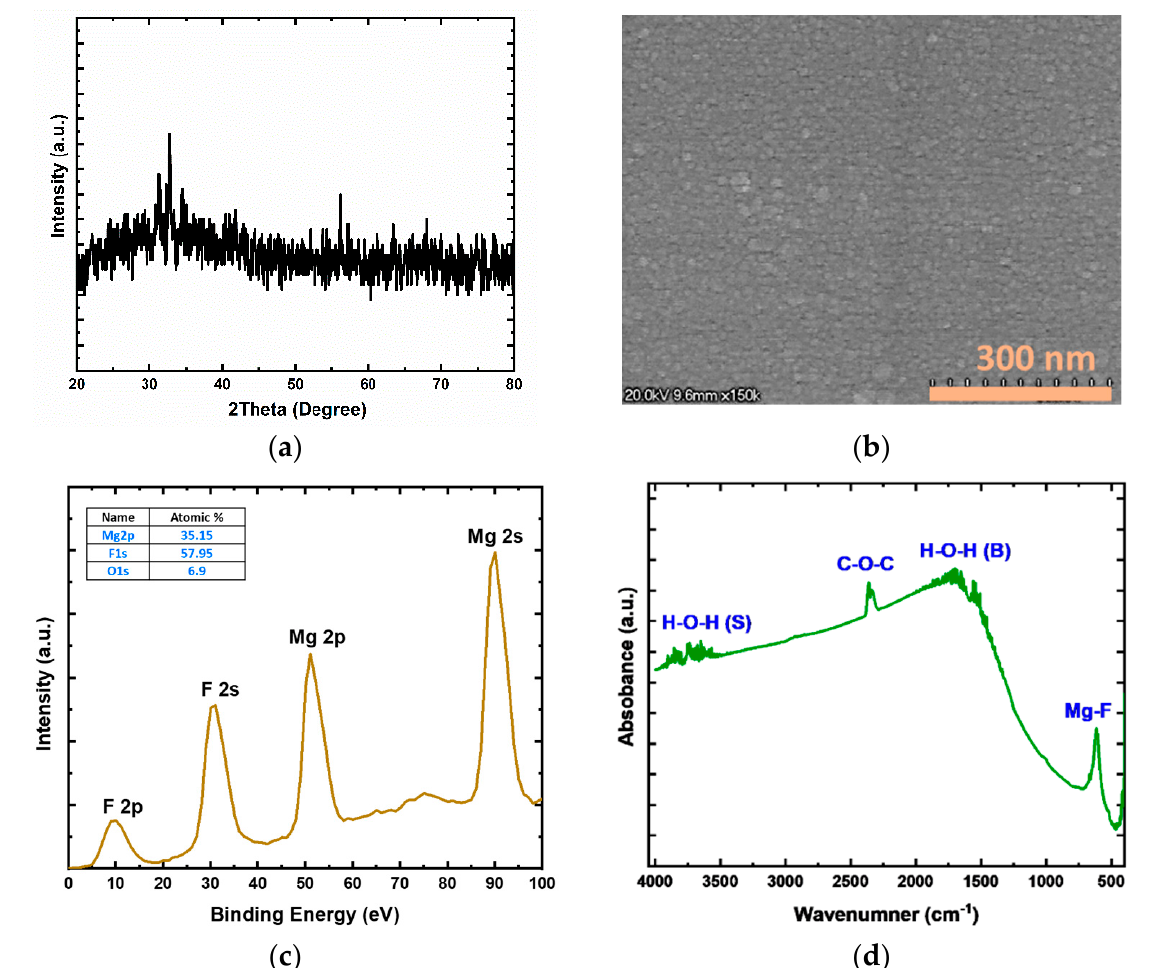
Figure 1. Structural and compositional analysis of MgF x thin film ( a ) XRD pattern of MgFx film; ( b ) SEM image of the surface; ( c ) XPS analysis with characteristics peaks and atomic percentages of magnesium and fluorine; ( d ) FTIR absorbance spectra. The XRD pattern of the MgF x thin-film proves that this film is amorphous, as